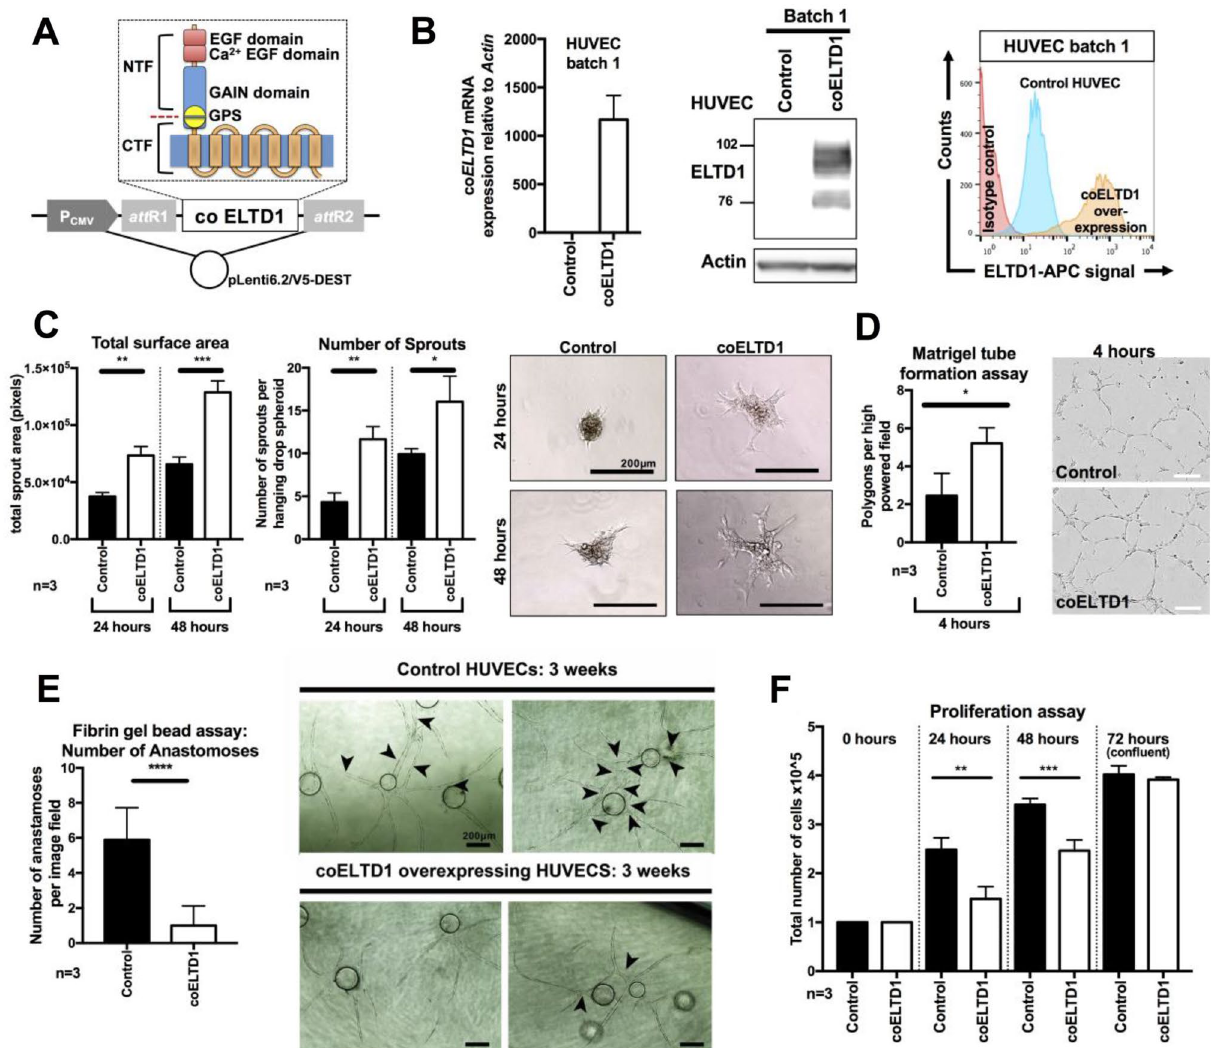
Figure 3. Co FL ELTD1/ADGRL4 stable overexpression in HUVECS induces the tip cell phenotype. ( A ) Illustration of full length codon optimised ADGRL4/ELTD1 within the pLenti6.2/V5-DEST lentiviral vector. ( B ) Stable overexpression of co FL ADGRL4/ELTD1 in HUVECs (batch 1) showed increased transcripts (qPCR), total protein (Western blot) and cell surface expression (FACS) compared to control HUVECs. HUVECS overexpressing co FL ADGRL4/ELTD1 showed ( C ) increased total spheroid surface area and number of sprouts, compared to controls at both 24 and 48 h; ( D ) increased capillary tube formation; ( E ) decreased number of vascular anastomoses/branches between adjacent vessels (arrowheads point to anastomotic branches); ( F ) reduced HUVEC